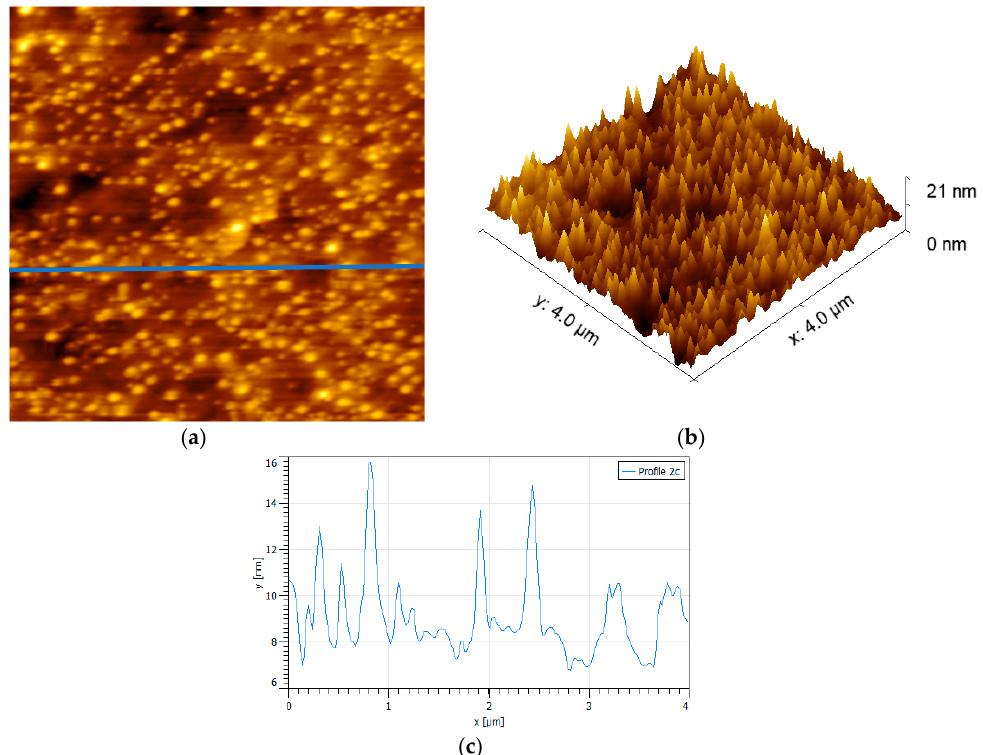
Figure 1. Surface {100} of polished pyrite ( a ) with 1 micron diamond paste and ( b ) with 0.25 micron diamond paste. Scan size is 10 × 10 μ m 2 . The 3D images of surfaces ( a ) and ( b ), respectively, are shown in ( c ) and ( d ). Height profiles corresponding to blue lines in ( a ) and ( b ), respectively, are shown in frames ( e ) and ( f ).